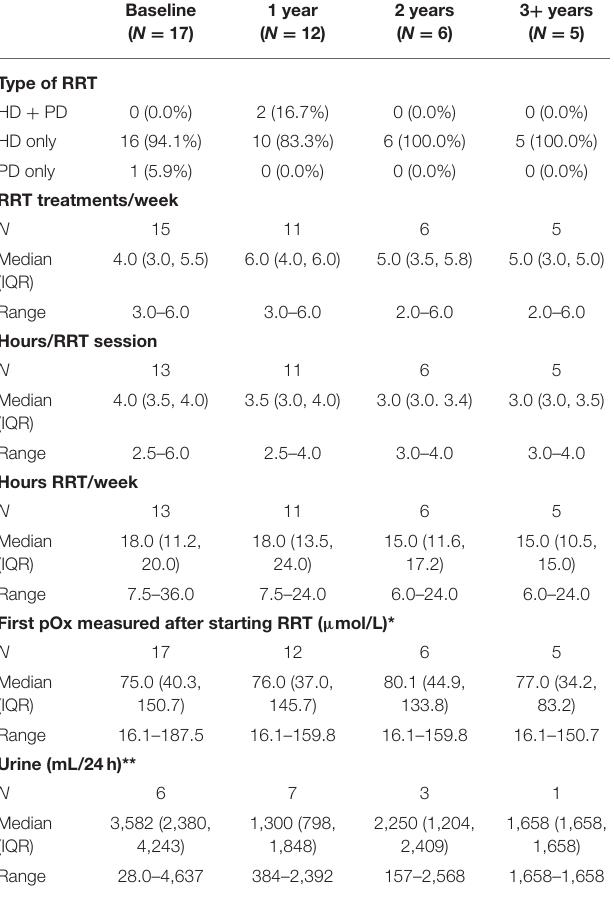
TABLE 3 | PH1 patients’ RRT regimen, plasma oxalate concentration, and urine output.